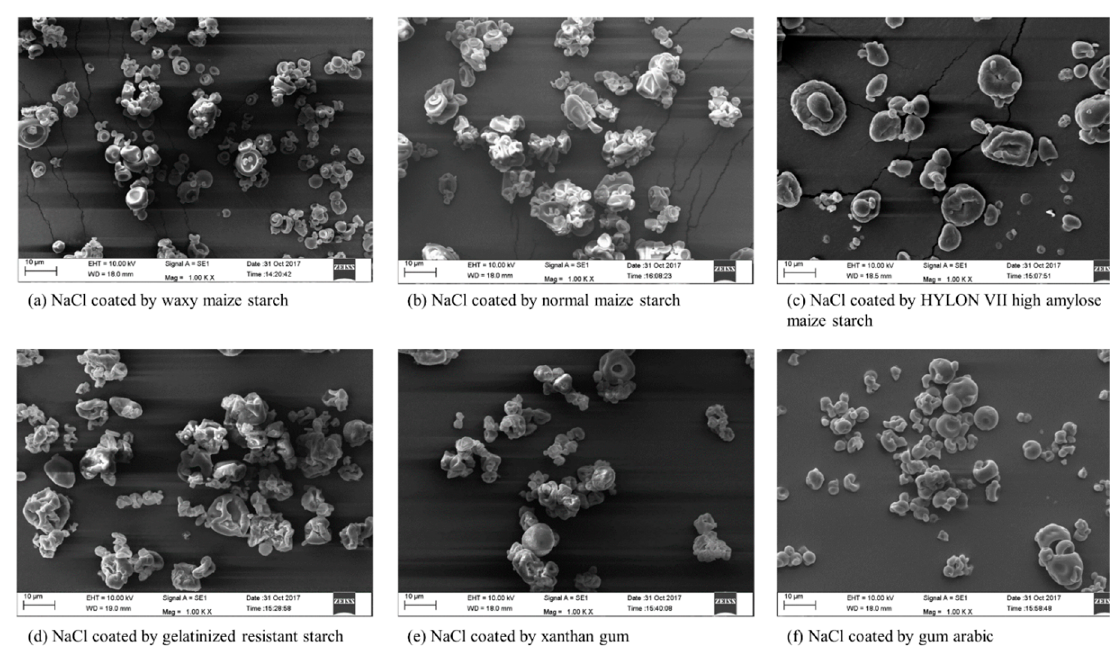
Figure 4. NaCl microparticles obtained from SEM.